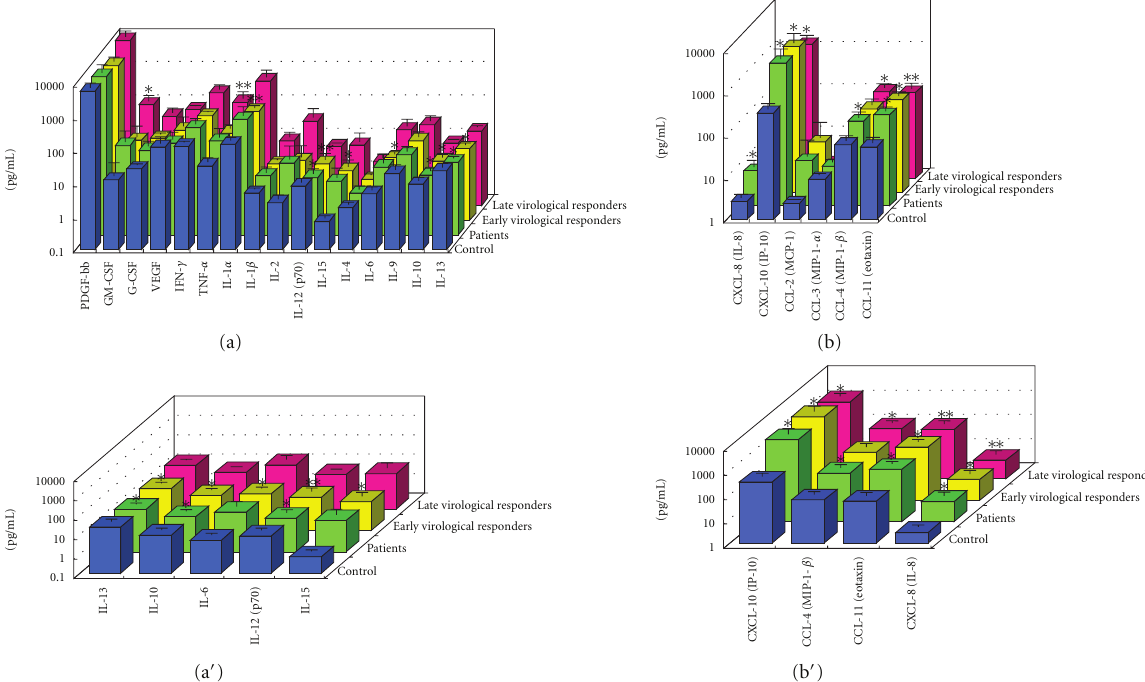
Figure 1: Levels of serum cytokines (a), (a (cid:3) ) and chemokines (b), (b (cid:3) ) at baseline in chronic hepatitis C patients with high viral load, genotype 1b (serotype I), and wild or intermediate types of ISDR. ISDR: interferon sensitivity determinin region. Significant di ff erence: ∗ P < 0 . 05, ∗∗ P < 0 . 1.